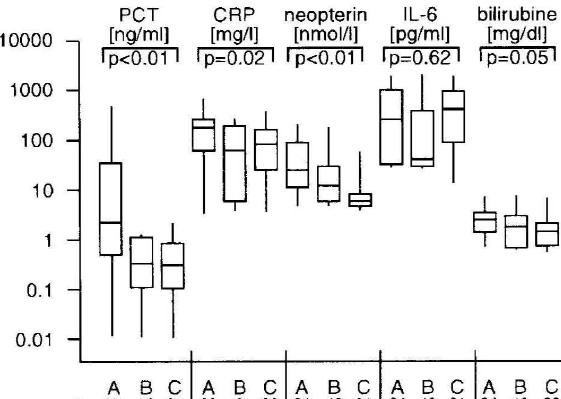
figure 2. Procaicitonin (PCT), (~>reactive protein (CRP), neopterin, interleukin-6 (IL-6), and bilirubin serum concentrations, obtained during the first 24 hr at1:er admission are depicted t(X 13 patients with the clinical diagnosis of biliary pancreatitis (A), a subgroup of (A), consisting of five of 13 patients with negative ERCP findings (B), and 19 patients with non biliary pancreatitis (C). The box-plot diagrams indicate the 25% and 75% percentiles, median, minimum, and maximum values; n=number of serum samples obtained in each group. Mann-Whitney test was performed to test for significant differences between groups (A) and (C). [From Brunk horst FM, et al. (45), reprinted with permission from The American College of